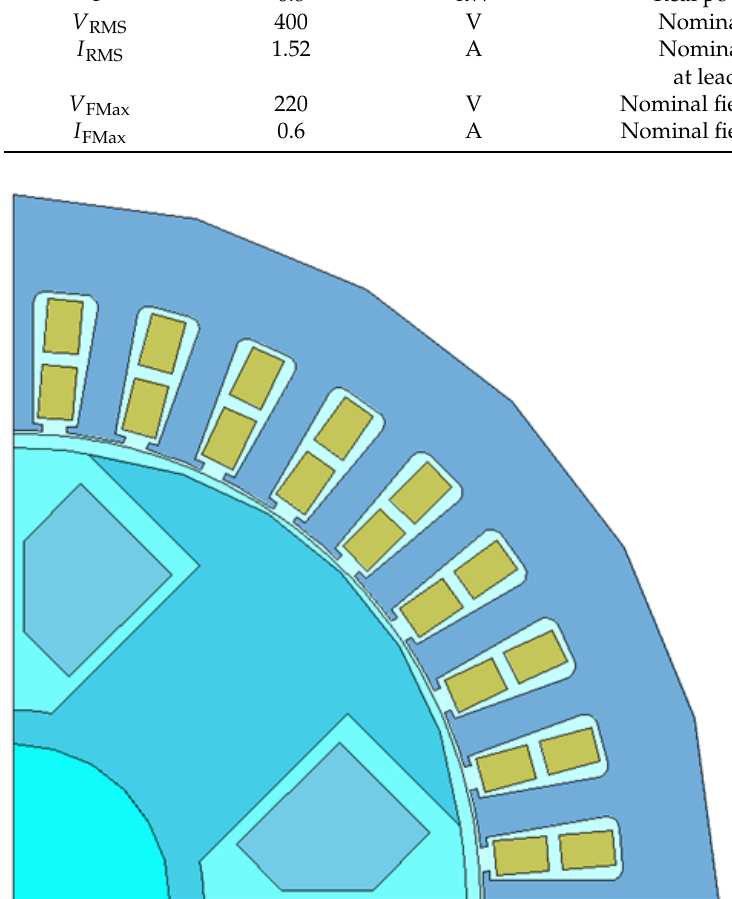
Figure 8. Quarter finite element model of the WRSESM developed in ANSYS